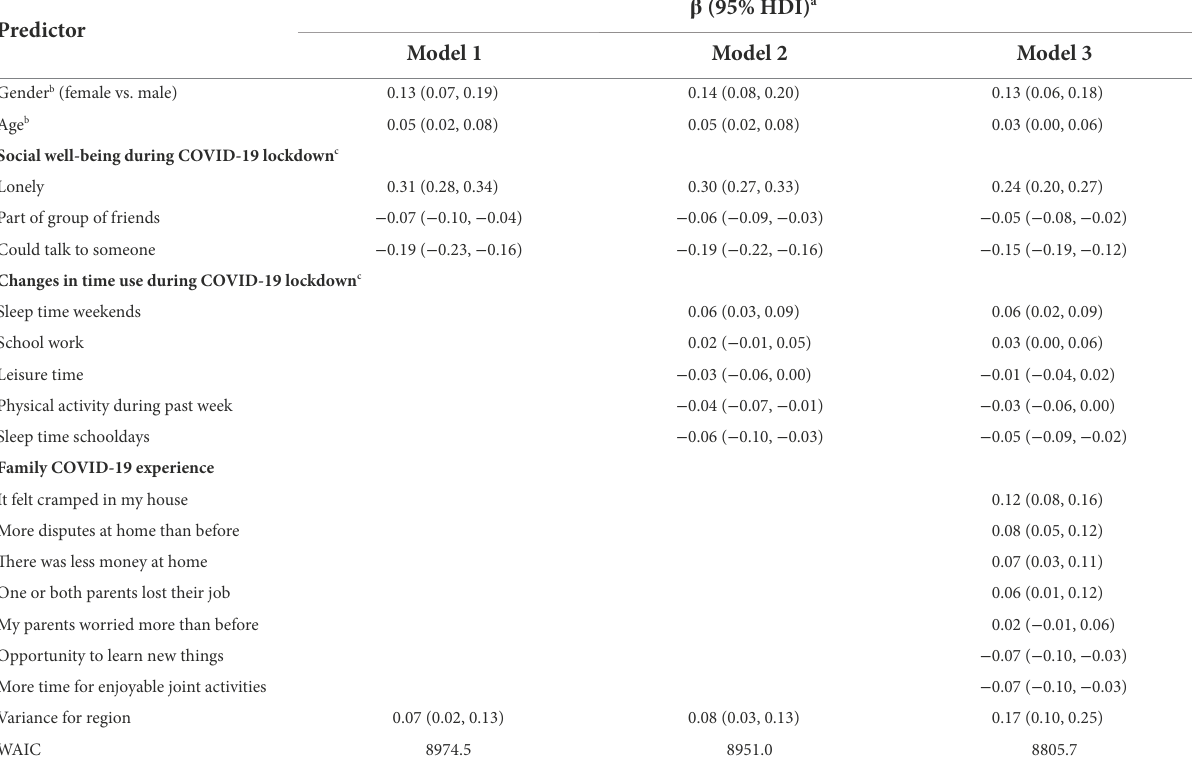
TABLE 2 Bayesian multilevel regression analysis of covariates predicting the level of perceived stress in adolescents during the spring 2020